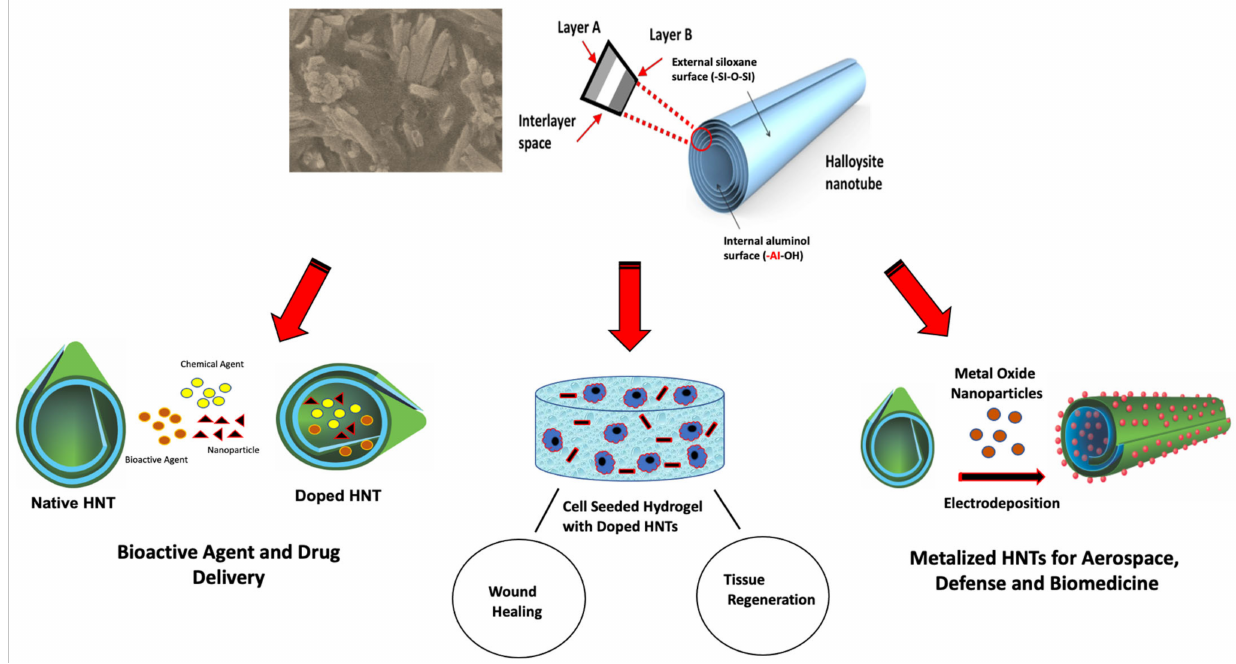
Figure 8. Native HNTs have been used as both nanocarriers and nanocontainers for aerospace, biomedicine, defense, and industrial